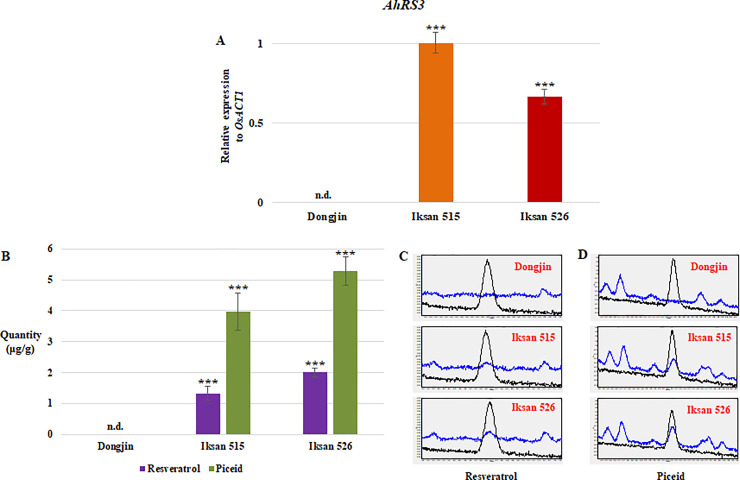
Analysis of AhRS3 expression and resveratrol and piceid biosynthesis in the developing seeds of I.515 and I.526, respectively, at 9 days after heading (DAH).(A) Expression of AhRS3 relative to that of the rice ACTIN 1 (OsACT1) gene (internal control). (B) Levels of resveratrol piceid in 9 DAH seeds of I.515 and I.526, respectively. (C, D) Chromatogram from UPLC analysis of resveratrol (C) and piceid (D). Black line indicates the standard, and blue line indicates the extract of Dongjin, I.515 and I.526 seeds at 9 DAH. Data represent mean ± standard deviation (SD). ***: p < 0.001. n.d.: not detected.